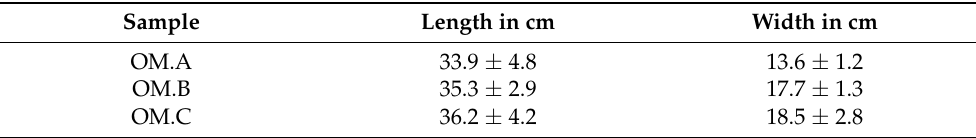
Table 2. Biometric parameters measured in the O. maxima cladodes. Sample Length in